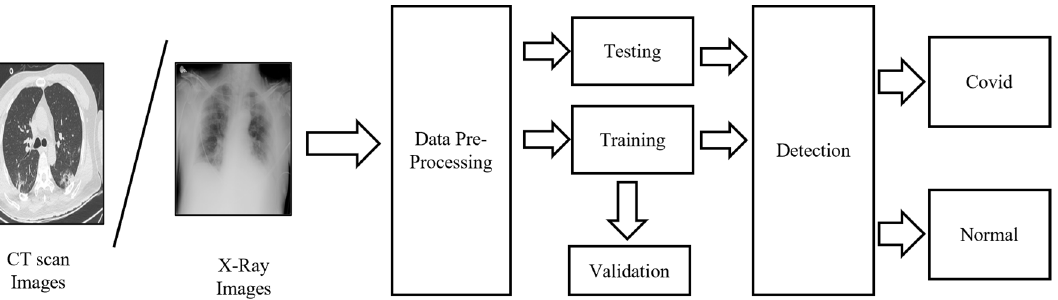
Figure 2. Steps for COVID-19 detection using image processing.